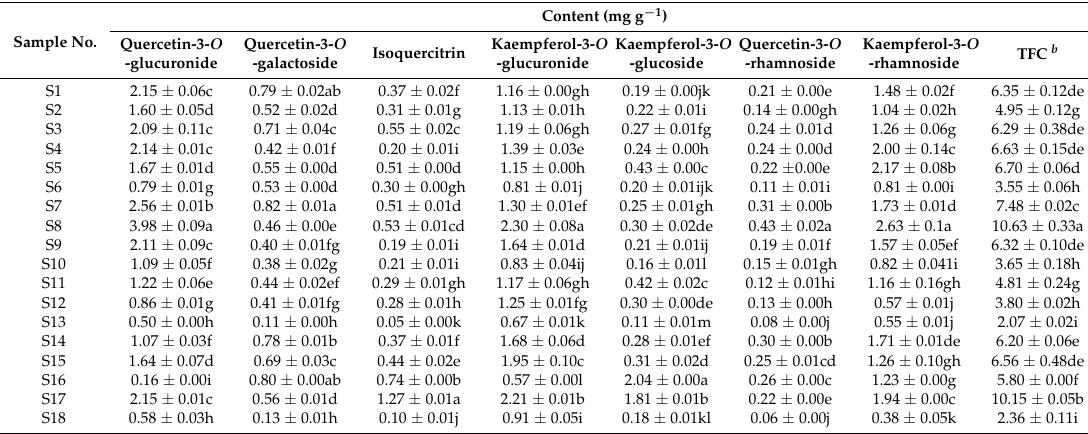
Table 5. Quantitative determination of seven flavonoids in 18 samples of C. paliurus leaves a .